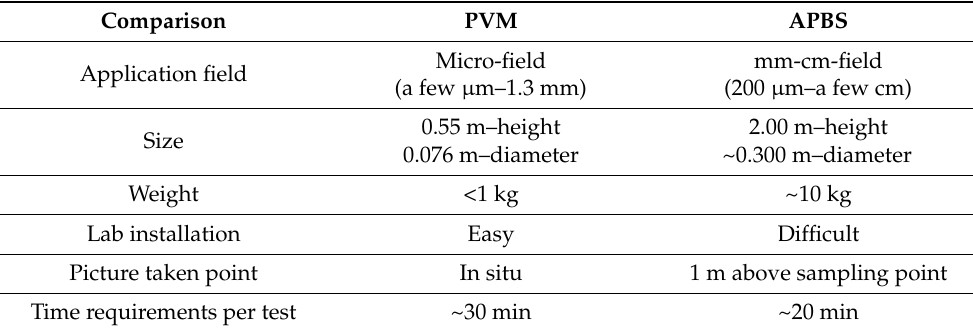
Table 3. Comparison of the PVM and APBS bubble size measurement techniques. Comparison